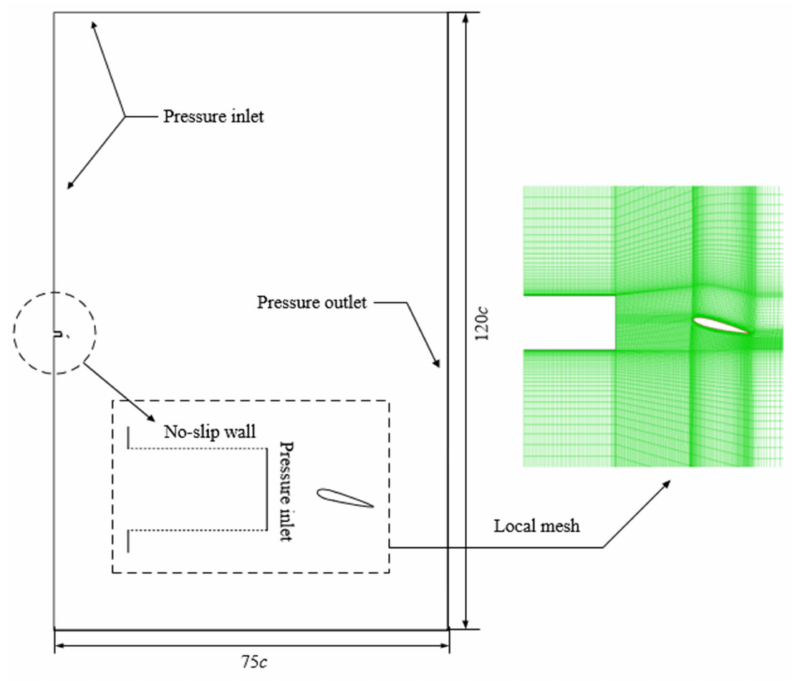
Figure 11. CFD computational domain and mesh.